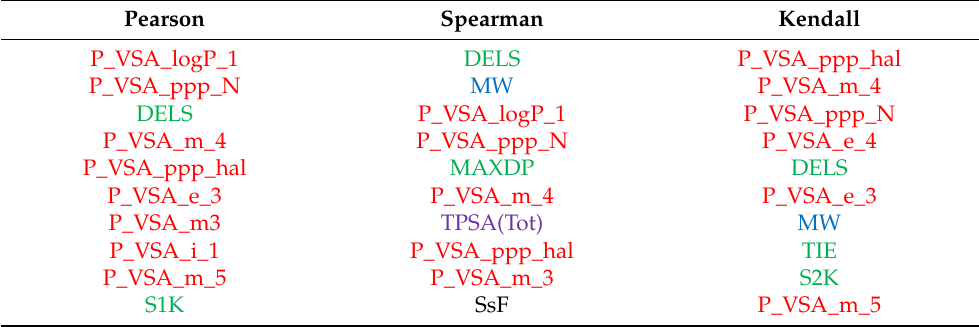
Table 2. The top 10 most important molecular descriptors obtained from DL-model based on 3 different correlation methods, i.e., Pearson, Spearman and Kendall. Color code: red (P-VSA); blue (constitutional); green (topological indices); purple (molecular properties); black (atom-type E-state